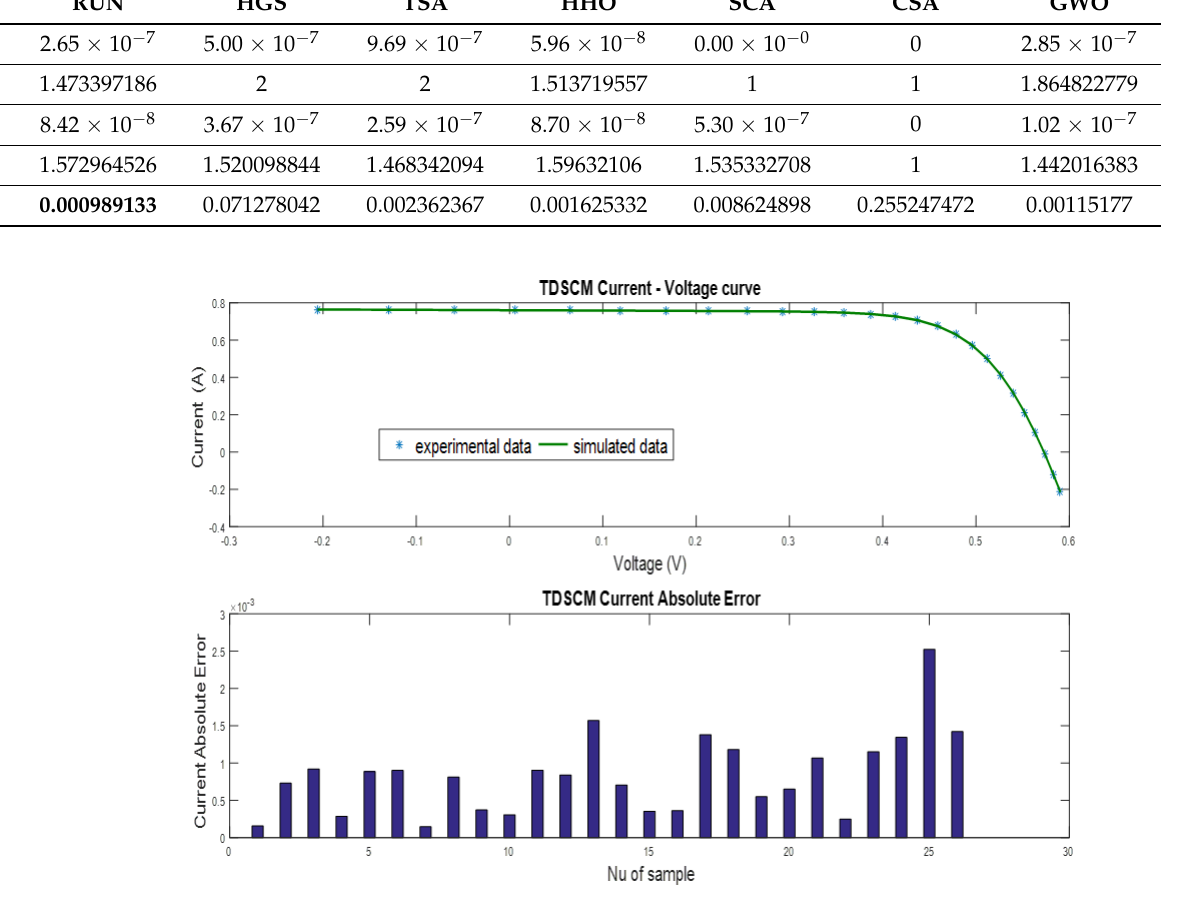
Figure 8. The I-V curve and current absolute error for TDSCM.